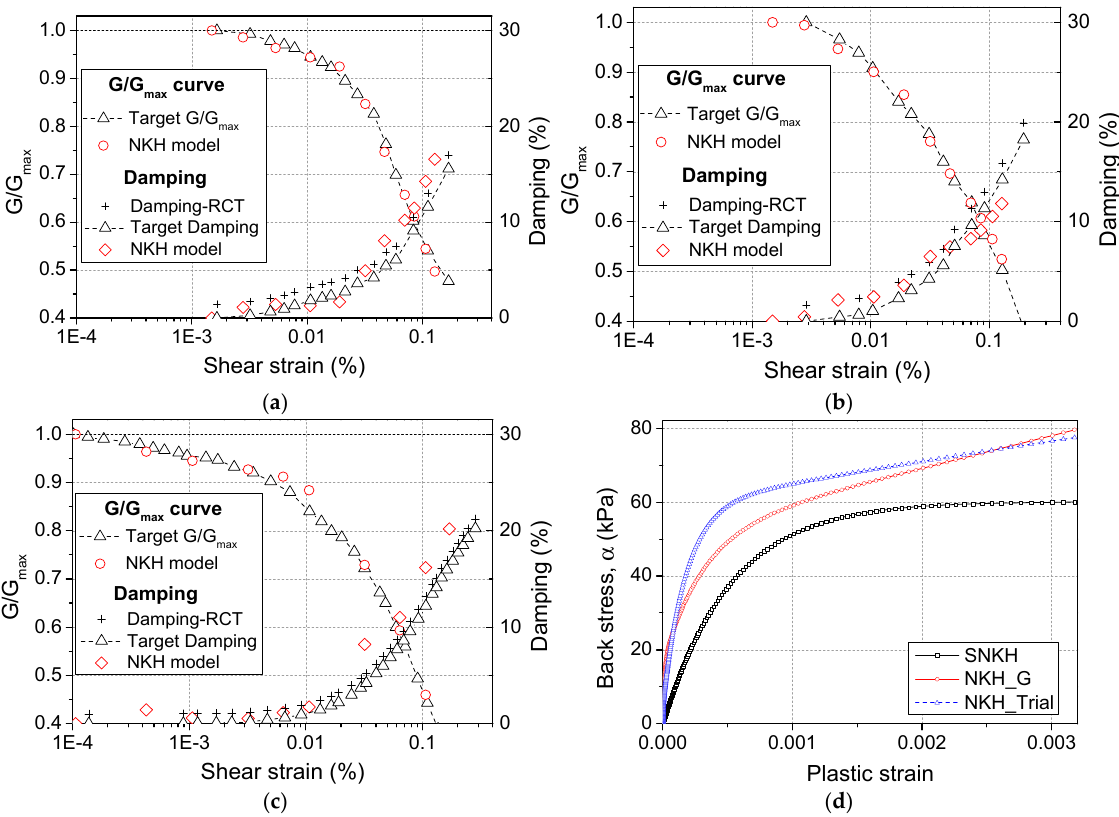
Figure 9. G/G max and damping curves with parameters of the NKH model (weighting factor, w = 1) for ( a ) silica sand, ( b ) mixture soil, and ( c ) Toyoura sand, and ( d ) back-stress curve for Toyoura sand.